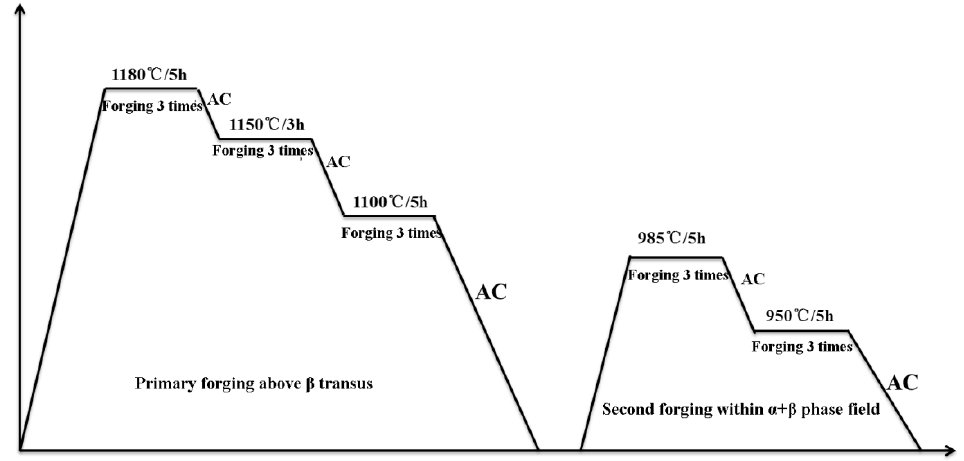
Figure 1. The details of the forging process of the Ti6242S alloy used in this study. The main parameters included temperature, soaking time, and cooling process. AC, air cooling.